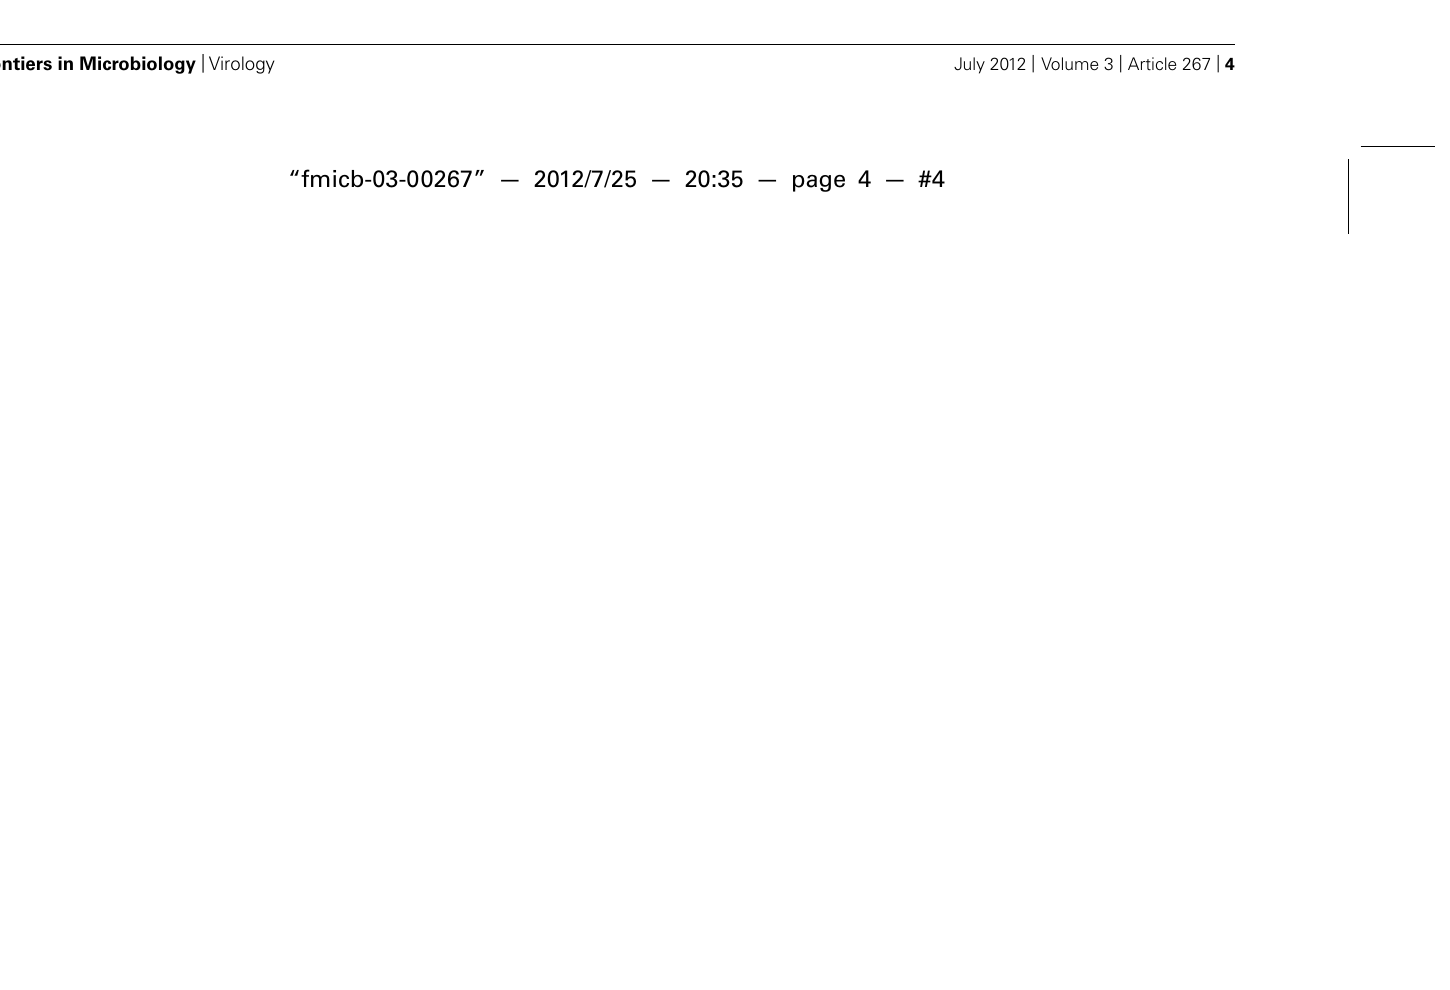
shown on the basis of previously reported review articles (Tokarev etal., 2009; Douglas etal., 2010; Evans etal., 2010).TGN, trans-Golgi